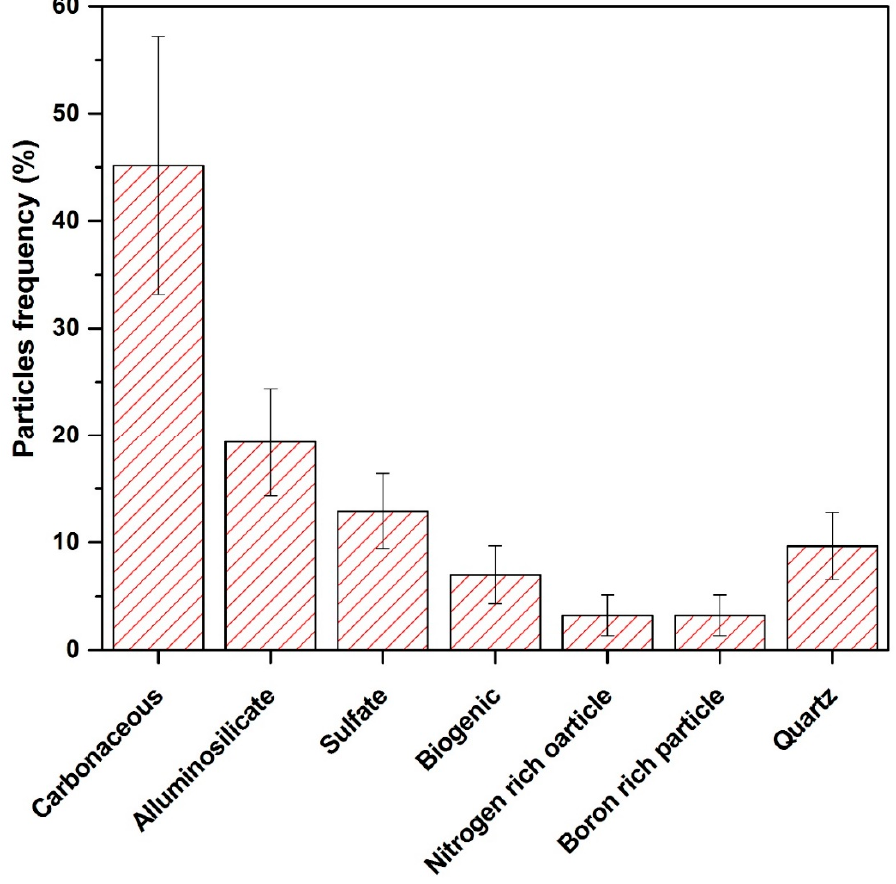
Figure 7. Percentage frequency of observed particles in the study area.